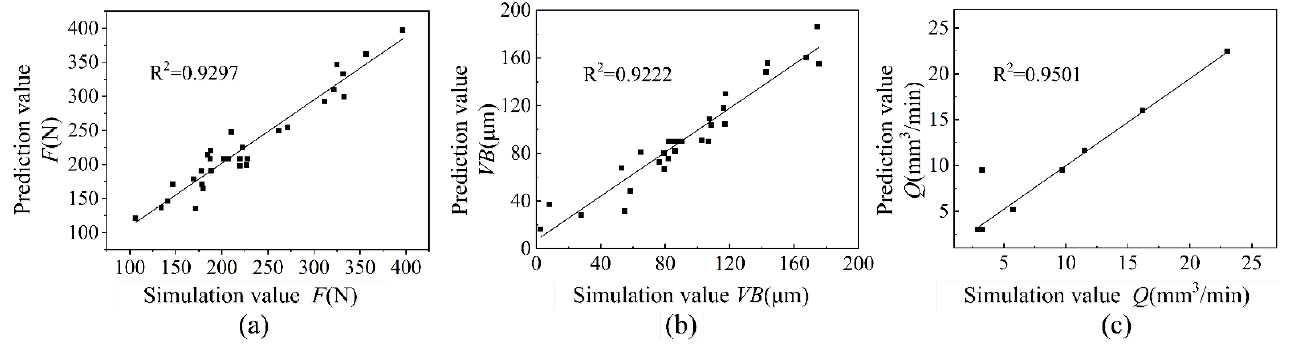
Figure 6. The relation between predicted and simulated values. ( a ) Cutting force F , ( b ) Tool flank wear VB , ( c ) Material removal rate Q.